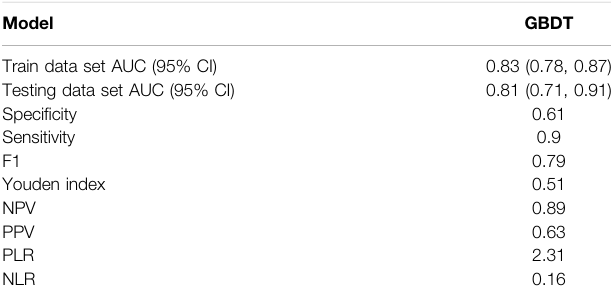
TABLE 4 | Results of LIME with GBDT model under seven most important variables. Four patients were random selected to interpret of sample prediction results using true negative, true positive, false negative, and false